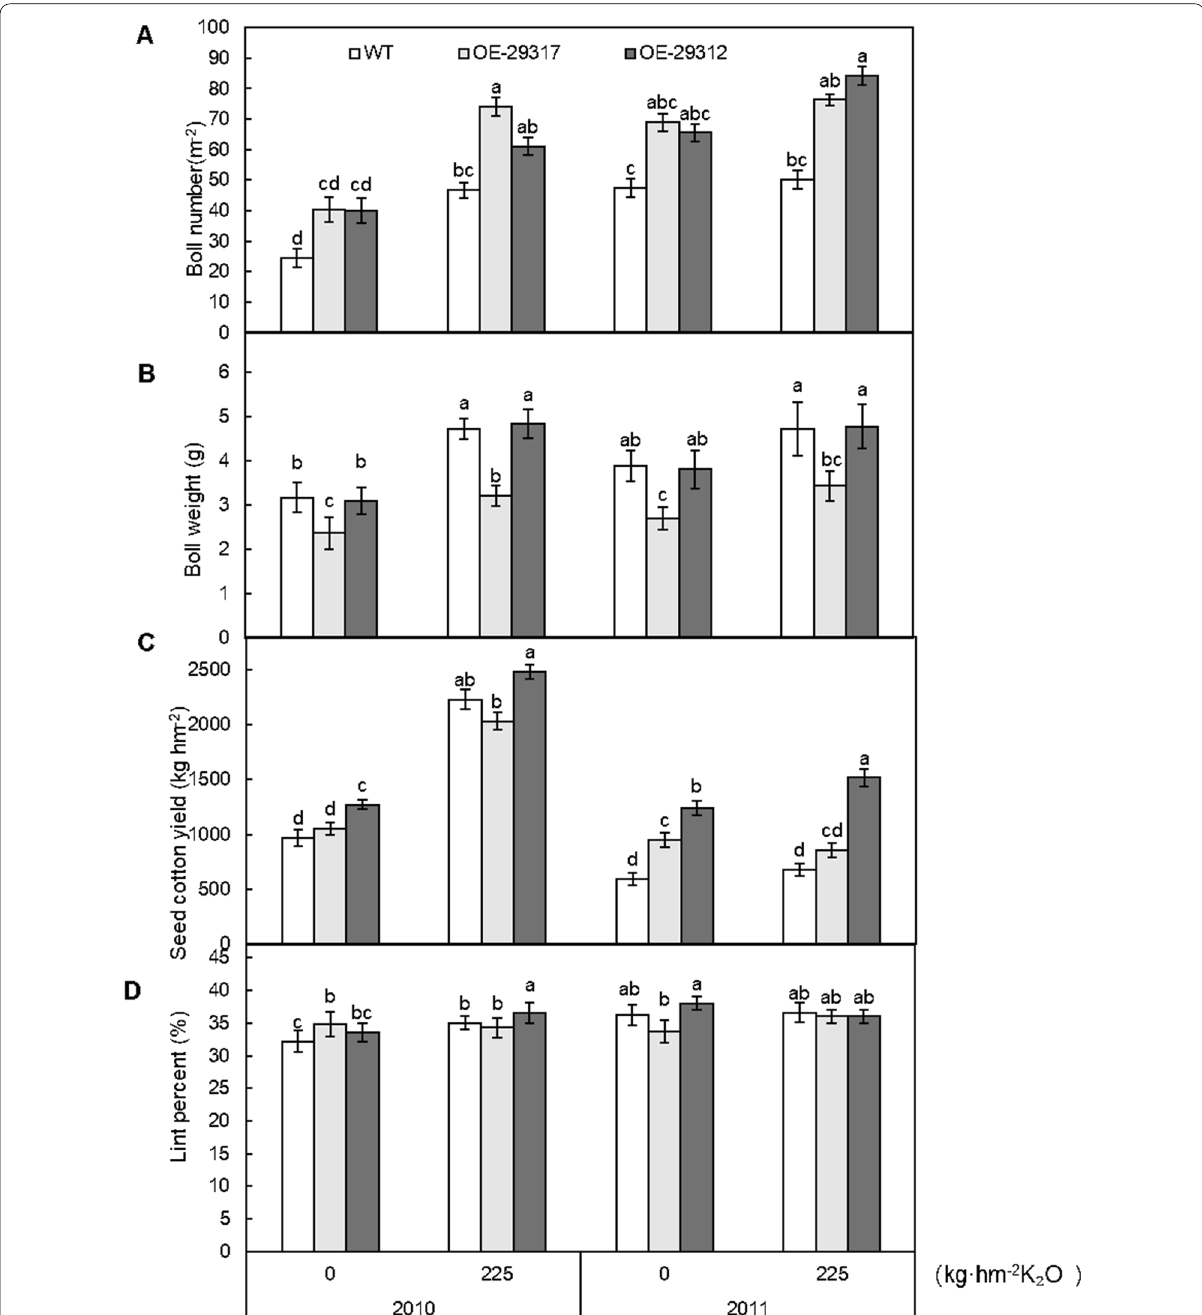
Fig. 3 Effects of Bacillus thuringiensis ( Bt ) gene on the boll number ( A ), boll weight ( B ), seed cotton yield ( C ), and lint percentage ( D ) in the field without or with potassium fertilizer (225